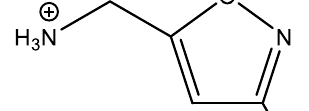
Figure 27. Hypericin. 7.12. Xanthohumol Xanthohumol is found in hops and, therefore, in beer. However, only in small amounts, as it is converted into other compounds during the brewing process. It has mul- tiple bioactivities, including anticancer, antidiabetic, antibacterial, anti-inflammatory ac- tivities [105]. The hydrogen bond is clearly defining the structure of the molecule. The strength of the hydrogen bond can be estimated from its OH chemical shift [106]. With a predicted value of 12.04 ppm, the hydrogen bond energy can be predicted as 7.35 Kcal/mole. Compound b of Figure 28 displayed moderate soluble epoxide hydrolase (sEH)-in- hibitory activity. It is isolated from Rubia philippinensis. The OH chemical shift is very high and a very small OH temperature coefficient was found. This structure has all the features necessary for being tautomeric. The authors speculated, based on HMBC data, that the compound could be tautomeric. They measured a 13 C NMR spectrum at 200 K and, as they